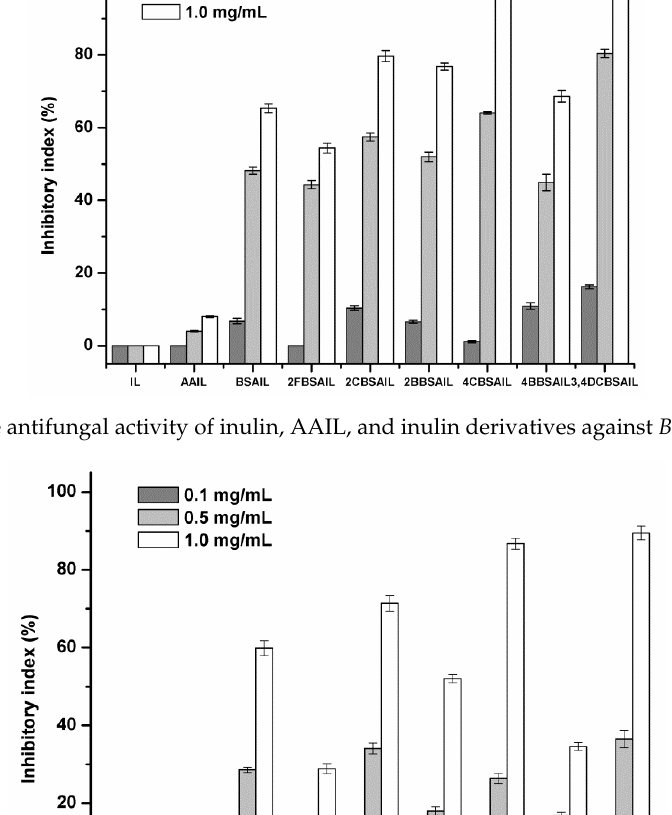
Figure 7. The antifungal activity of inulin, AAIL, and inulin derivatives against Fusarium oxysporum f. sp. niveum.